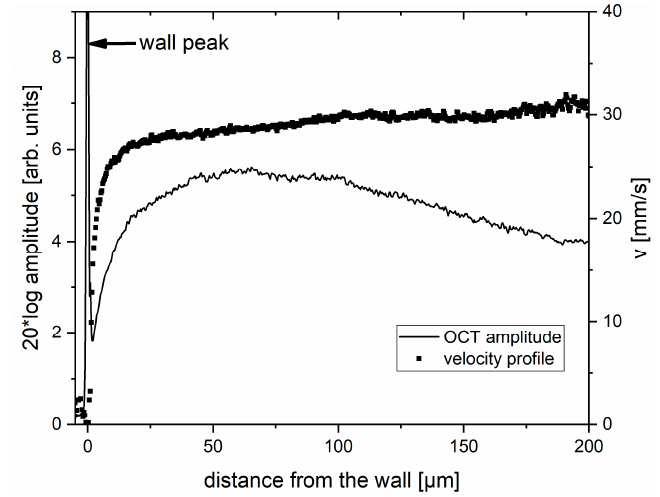
Figure 3. An example of a measured flow velocity profile (dots) together with the corresponding OCT amplitude signal (solid line) at the flow rate of 158 mL/min. The peak in the amplitude signal due to the tube wall is marked with an arrow.